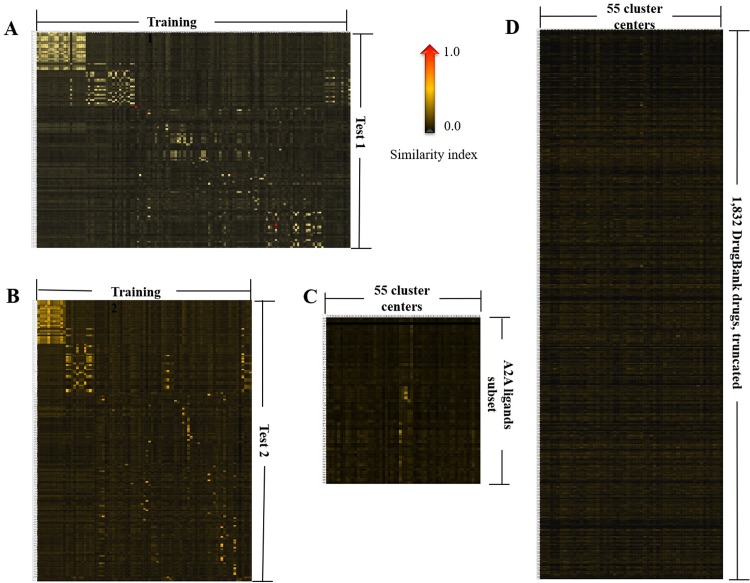
The heat map demonstration for binary fingerprint similarities between training 1 and test 1 (A), training 2 and test 2 (B), the 55 representations of the 268 compounds and the subset of 75 A2A ligands (C), as well as the 55 representations and the 1,832 DrugBank drugs (D). The heat map of 1,832 drugs was truncated due to space limitation. The heat maps were generated using Schrodinger Canvas, as described in details in Materials and Methods. The lowest similarity (0.0) was shown in black, whereas the highest similarity (1.0) was shown in red. See supplementary data for a zoomed in version for each panel.